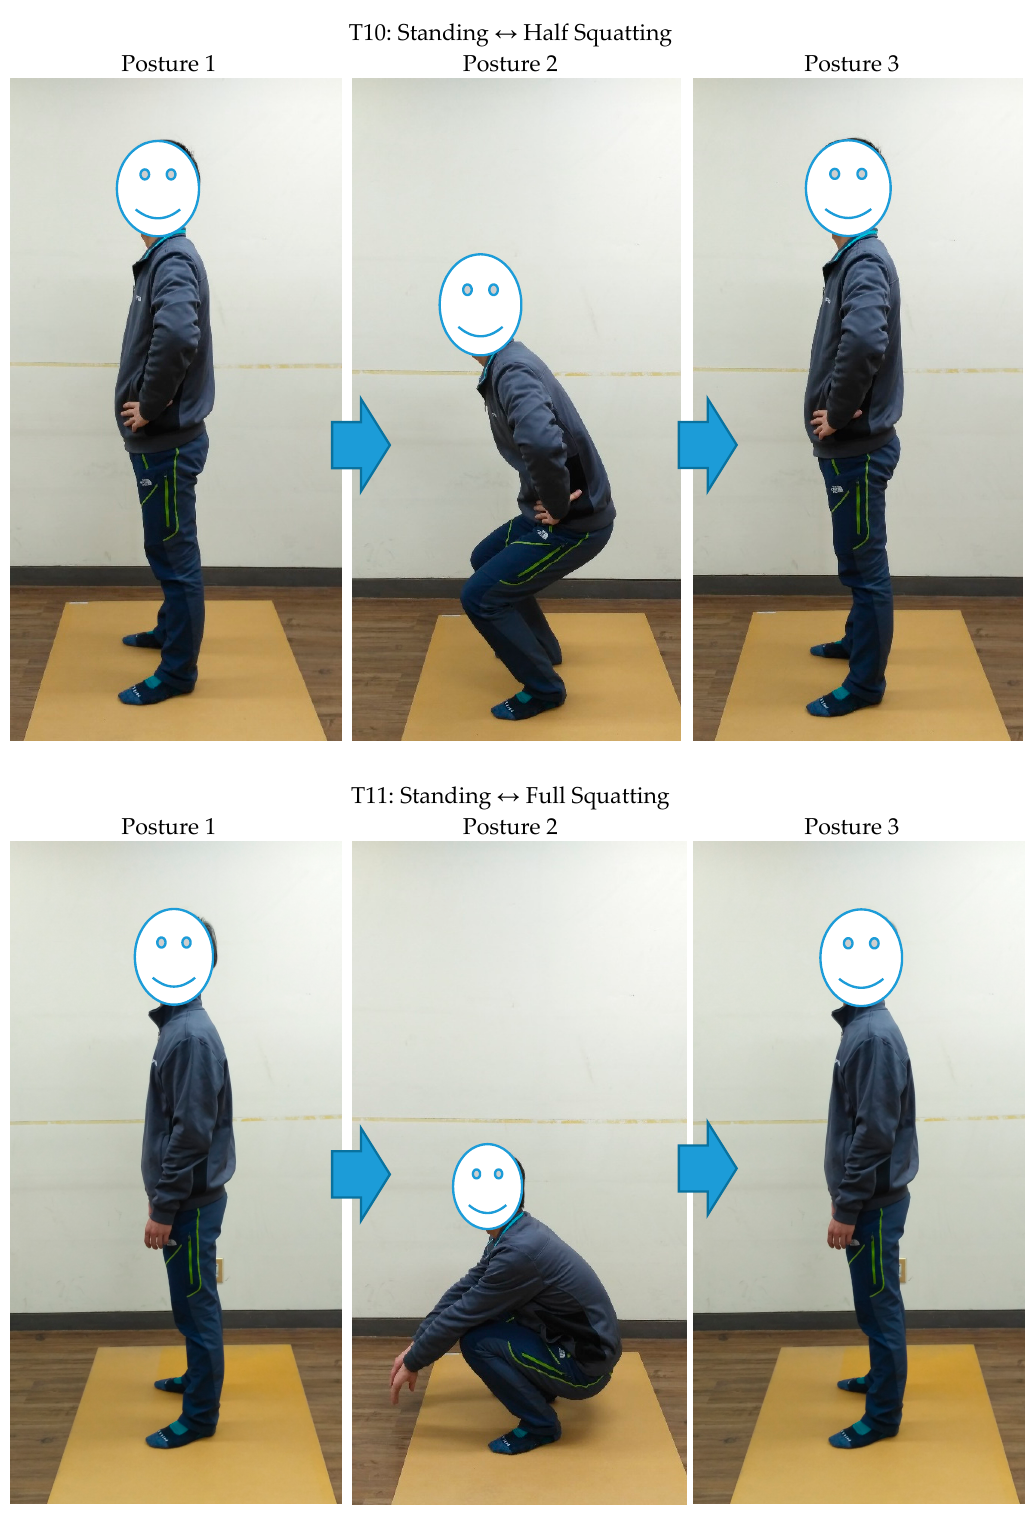
Figure A1. Schematic Representations of the Experimental Tasks.